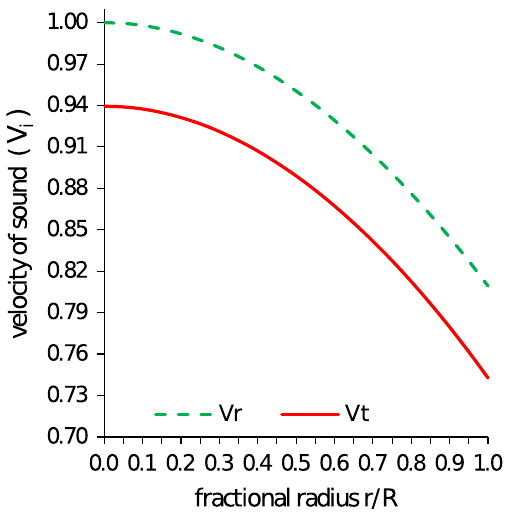
Fig. 4 Behavior of the sound speed V with respect to the fractional radial distance ( r / R ) for RX J 1856-37. For plotting this figure we have employed the same data set of numerical values as used in Figs. 1, 2 and